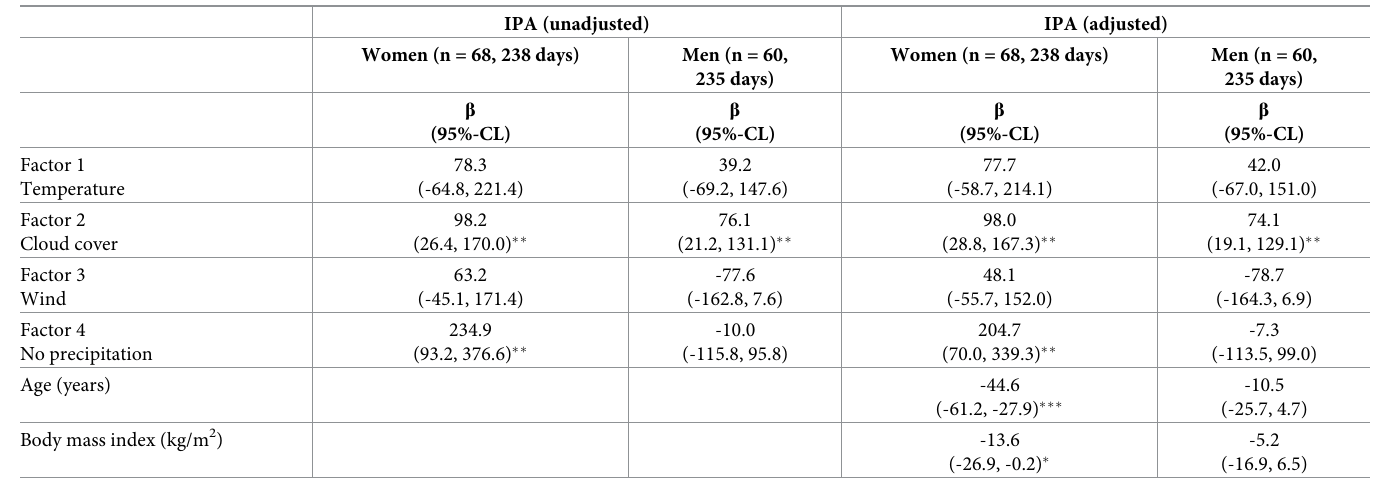
Table 5. Association of IPA (average accelerometer CPM) and meteorological